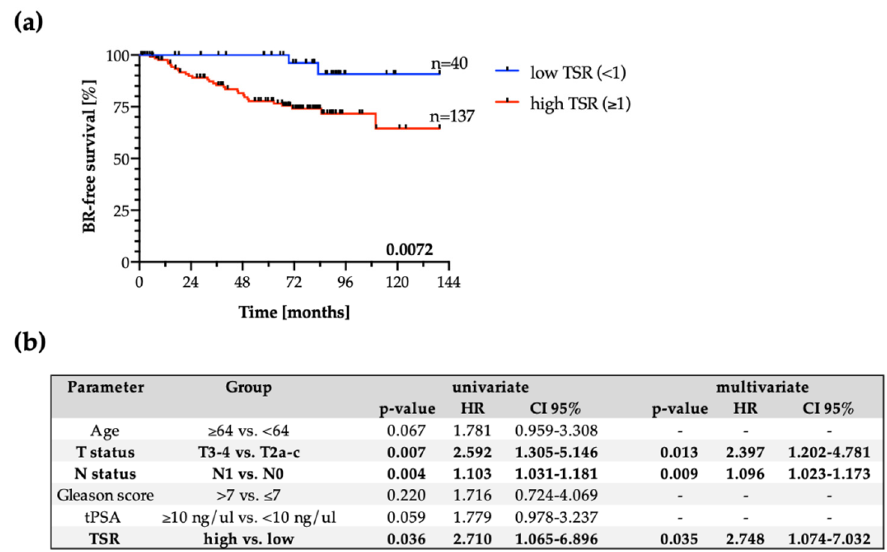
Figure 4. Clinical significance of TSR in a validation cohort. ( a ) Kaplan–Meier estimates of time to biochemical recurrence (BR) in validation cohort, n = 209. Note that not all patients are included in Kaplan–Meier analysis as the timepoints of BR occurrence for some patients were missing. ( b ) Uni- and multivariate analysis in the whole validation cohort. Statistically significant results are bolded.